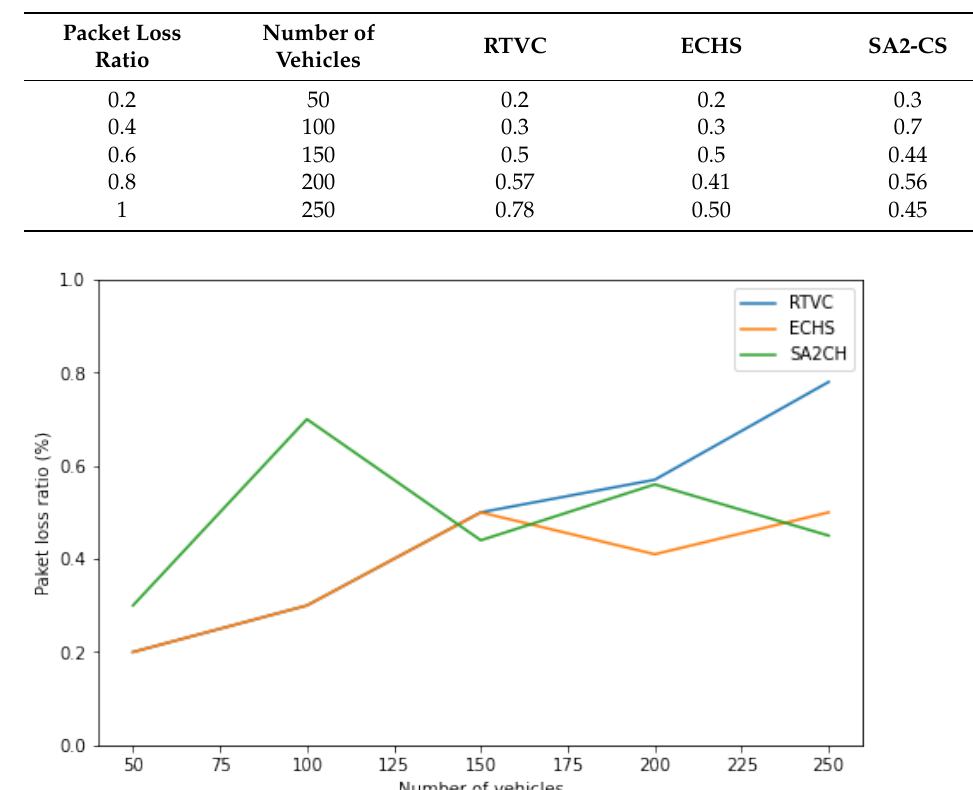
Table 5. Analysis of Packet Loss Ratio.